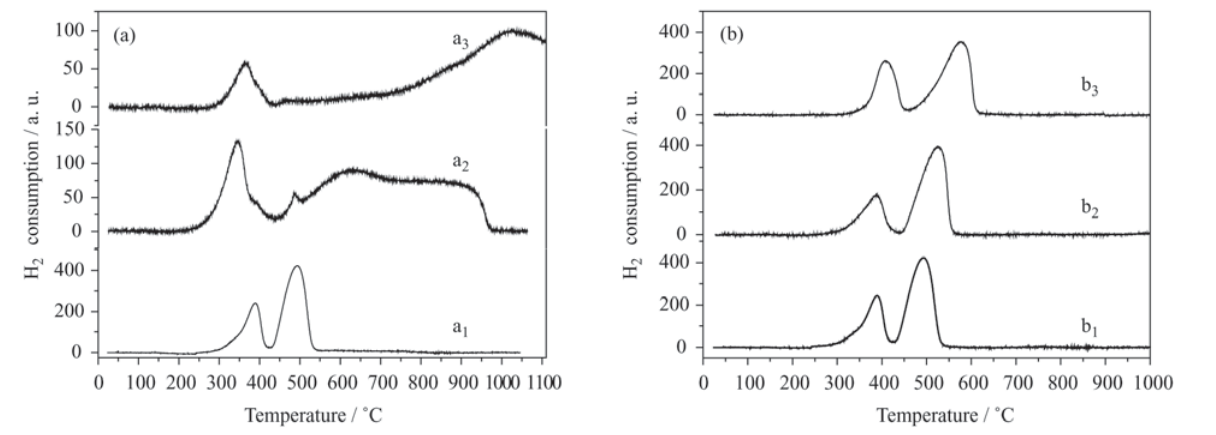
Figure 7. Temperature programmed reduction profiles of perovskites calcined at 900 °C for 10 h. a) LaNi x = 0.4, (a